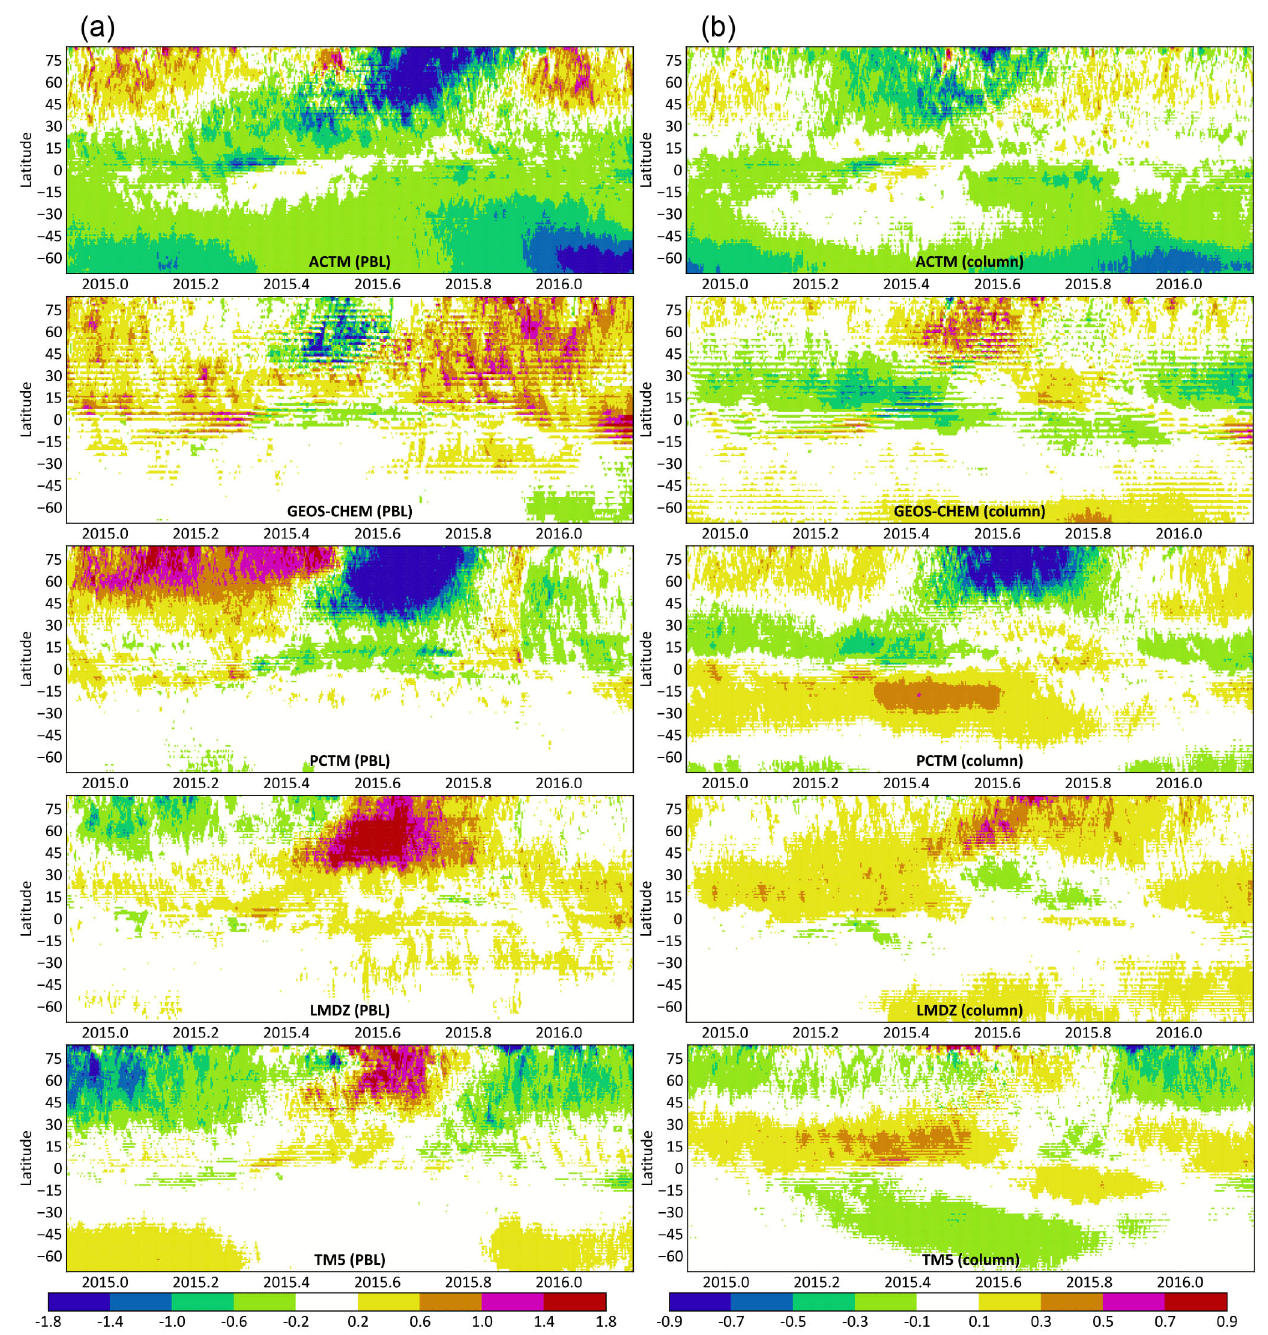
Figure 3. The zonal average difference between each model (ACTM, GEOS Chem, LMDZ, PCTM and TM5) and the cross-model median at 13:30 local time, in ppm CO 2 , between 1 December 2014 (2014.915) and 1 March 2016 (2016.164). (a) depicts differences in the lowest 150hPa, which is an approximation for the PBL. (b) depicts differences in column averaged CO 2 . Each column has its own color bar. Since transport differences in the total column are smaller than in the PBL, the dynamic range of (b) is half that of (a)